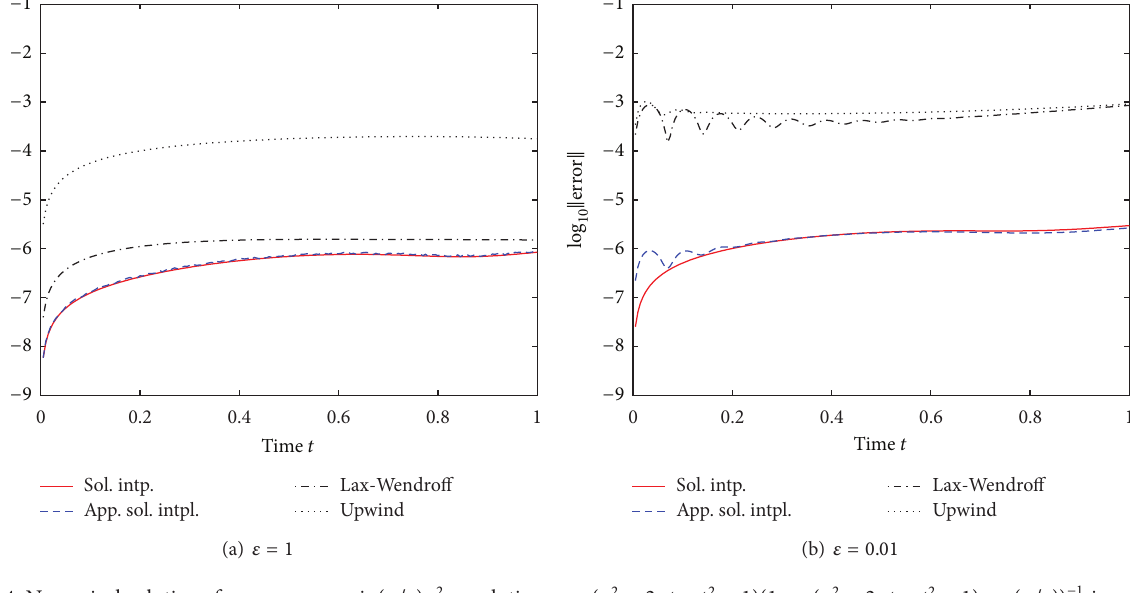
Figure 4: Numerical solutions for 𝑢 𝑡 + 𝑎𝑢 𝑥 = sin (𝑥/𝜀)𝑢 2 : a solution 𝑢 = (𝑥 2 − 2𝑥𝑡 + 𝑡 2 + 1)(1 + 𝜀(𝑥 2 − 2𝑥𝑡 + 𝑡 2 + 1) cos (𝑥/𝜀)) −1 is used to generate initial/boundary conditions and measure